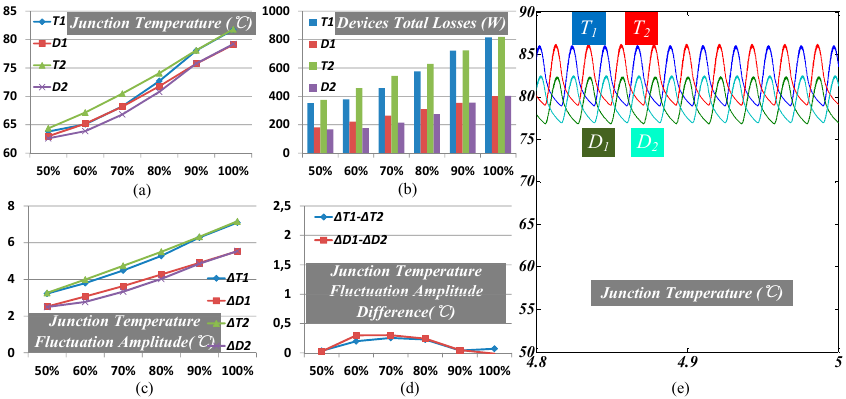
Figure 6. Single module result: ( a ) junction temperature; ( b ) devices loss; ( c ) junction temperature fluctuation; ( d ) temperature fluctuation difference; and ( e ) detailed temperature result in 100% load.